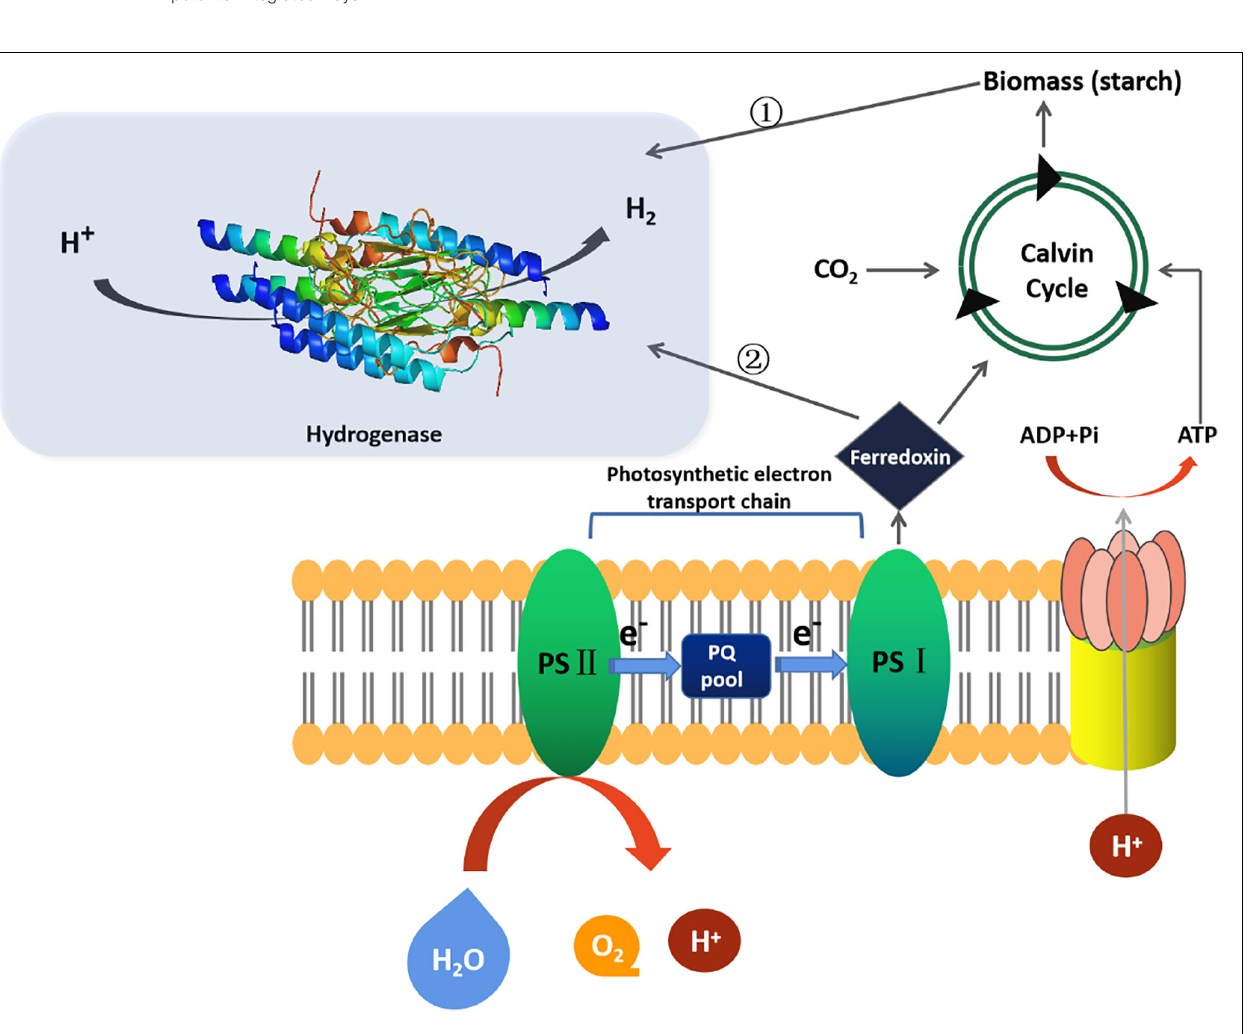
FIGURE 1 | Microalgae biohydrogen production in different routes.